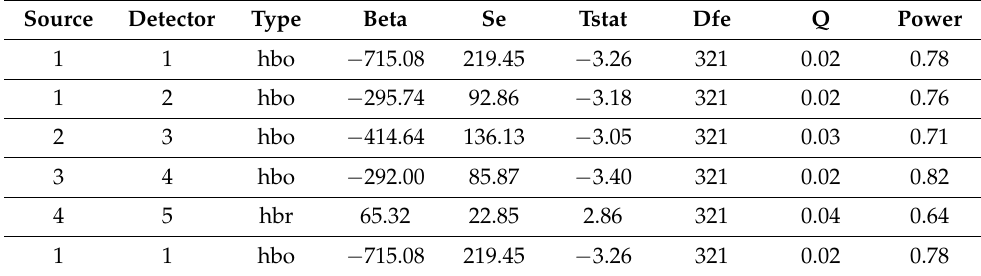
Table A7. t -test statistics for each channel (source–detector pair). Warrier 2 Left–Lotus